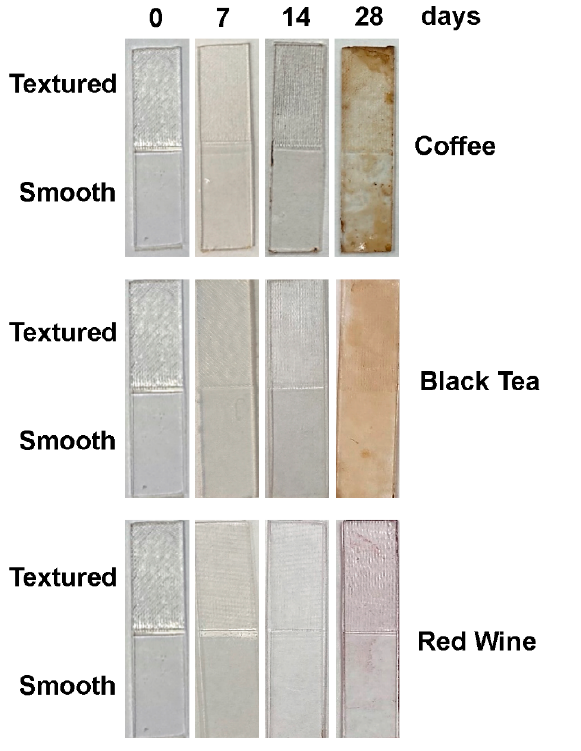
Figure 3. Representative examples of the copolyester retainer materials after staining by the different staining solutions at different time points. Table 4. NBS values for copolyester retainer specimens with different surface textures at different times after staining in different solutions (mean NBS value ± standard